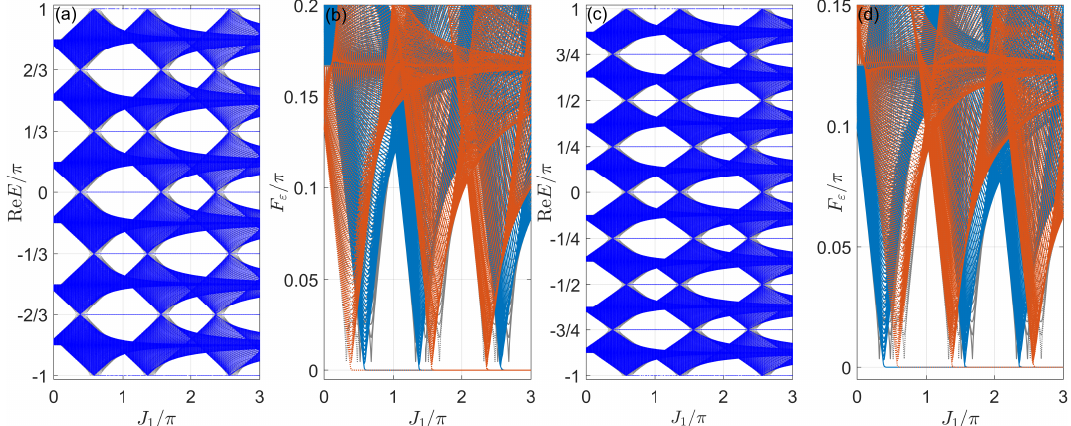
[ Eq. (26) ] and U [ ob- 1 / 3 1 / 4 under both PBC and OBC. Other 1 and 1 / 3 ( = F π ) and F 3 2 π/ 3 = F ( = F ) and F π/ ( = F π ) of 4 3 π/ 4 2 0